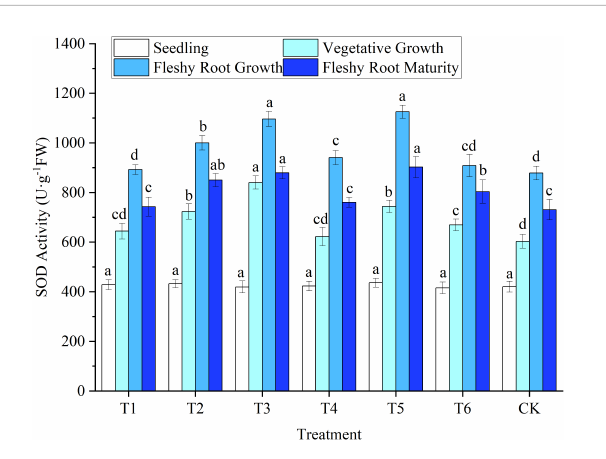
FIGURE 5 Response of superoxide dismutase activity in woad plants in different water de fi cits. Different lowercase letters in the same column mean the signi fi cant differences among treatments according to LSD ( P < 0.05). Data were presented as mean ± SE (n = 3).